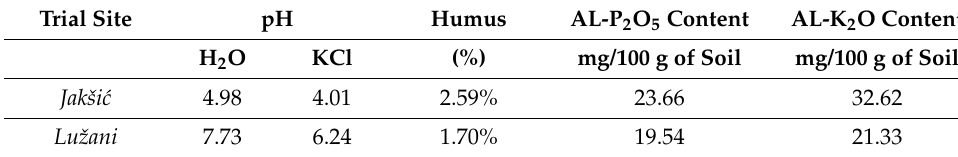
and the soil at the L experimental site into the group of well-supplied soils. The soils in the experimental plots J and L were very and slightly acidic, respectively (Table 2). Table 2. Soil type and some soil properties at the trial sites Jakši´c and Lužani. Trial Site